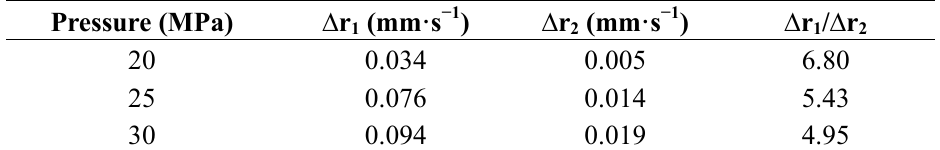
Table 2. The average filling rate of stage 1 and stage 2 at different pressure